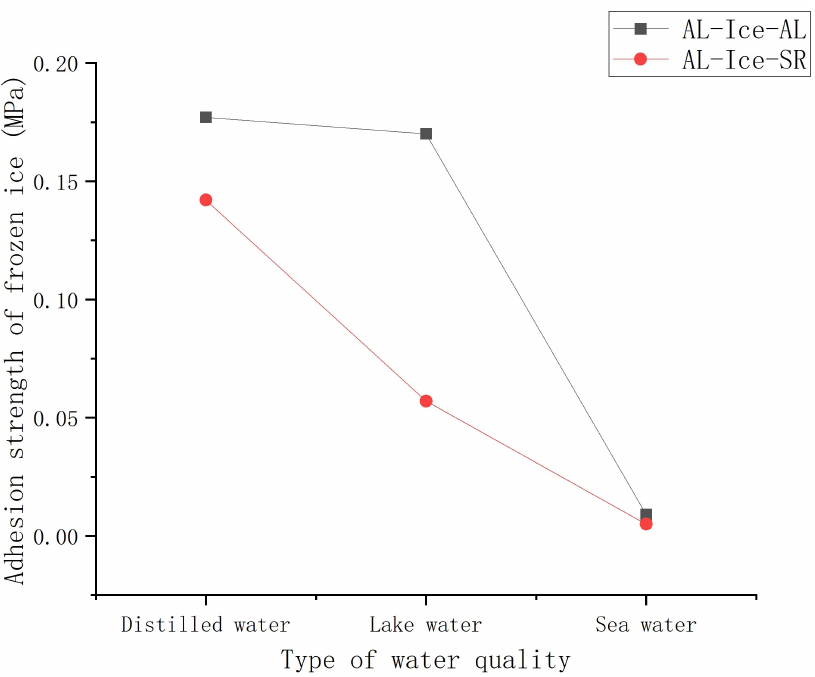
Figure 7. Adhesion strength of frozen ice under different water quality and different materials.